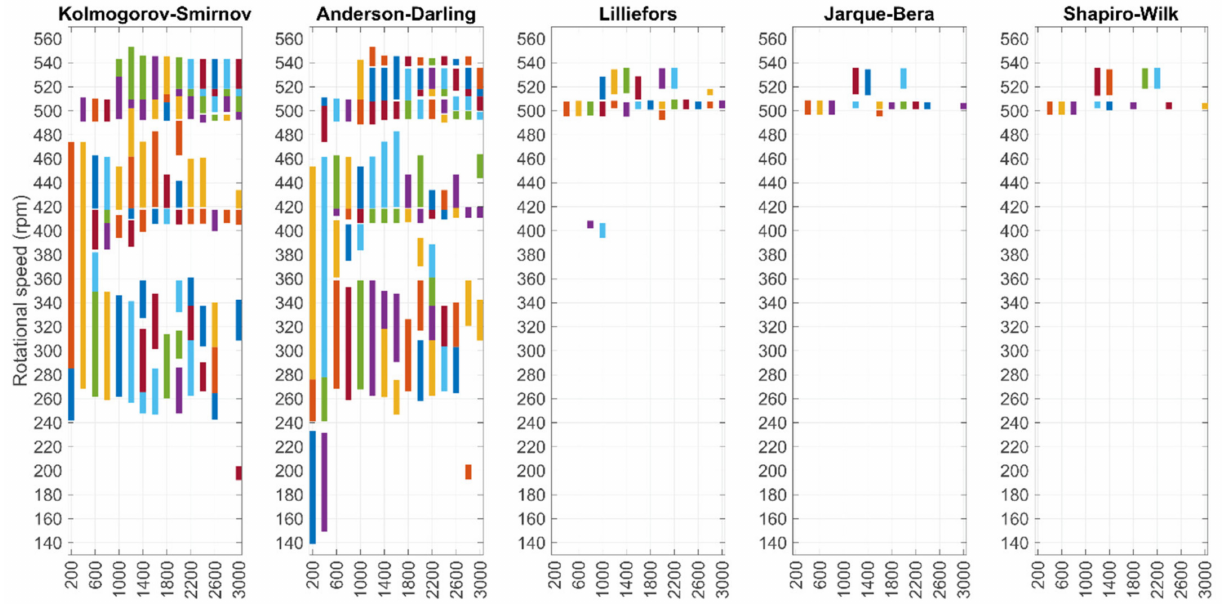
Figure 13. Speed ranges in selected training subsets based on system identification with five different hypothesis tests applied. Values on horizontal axis represent the sample size (N) and the vertical lines with different colors represent selected non-overlapping